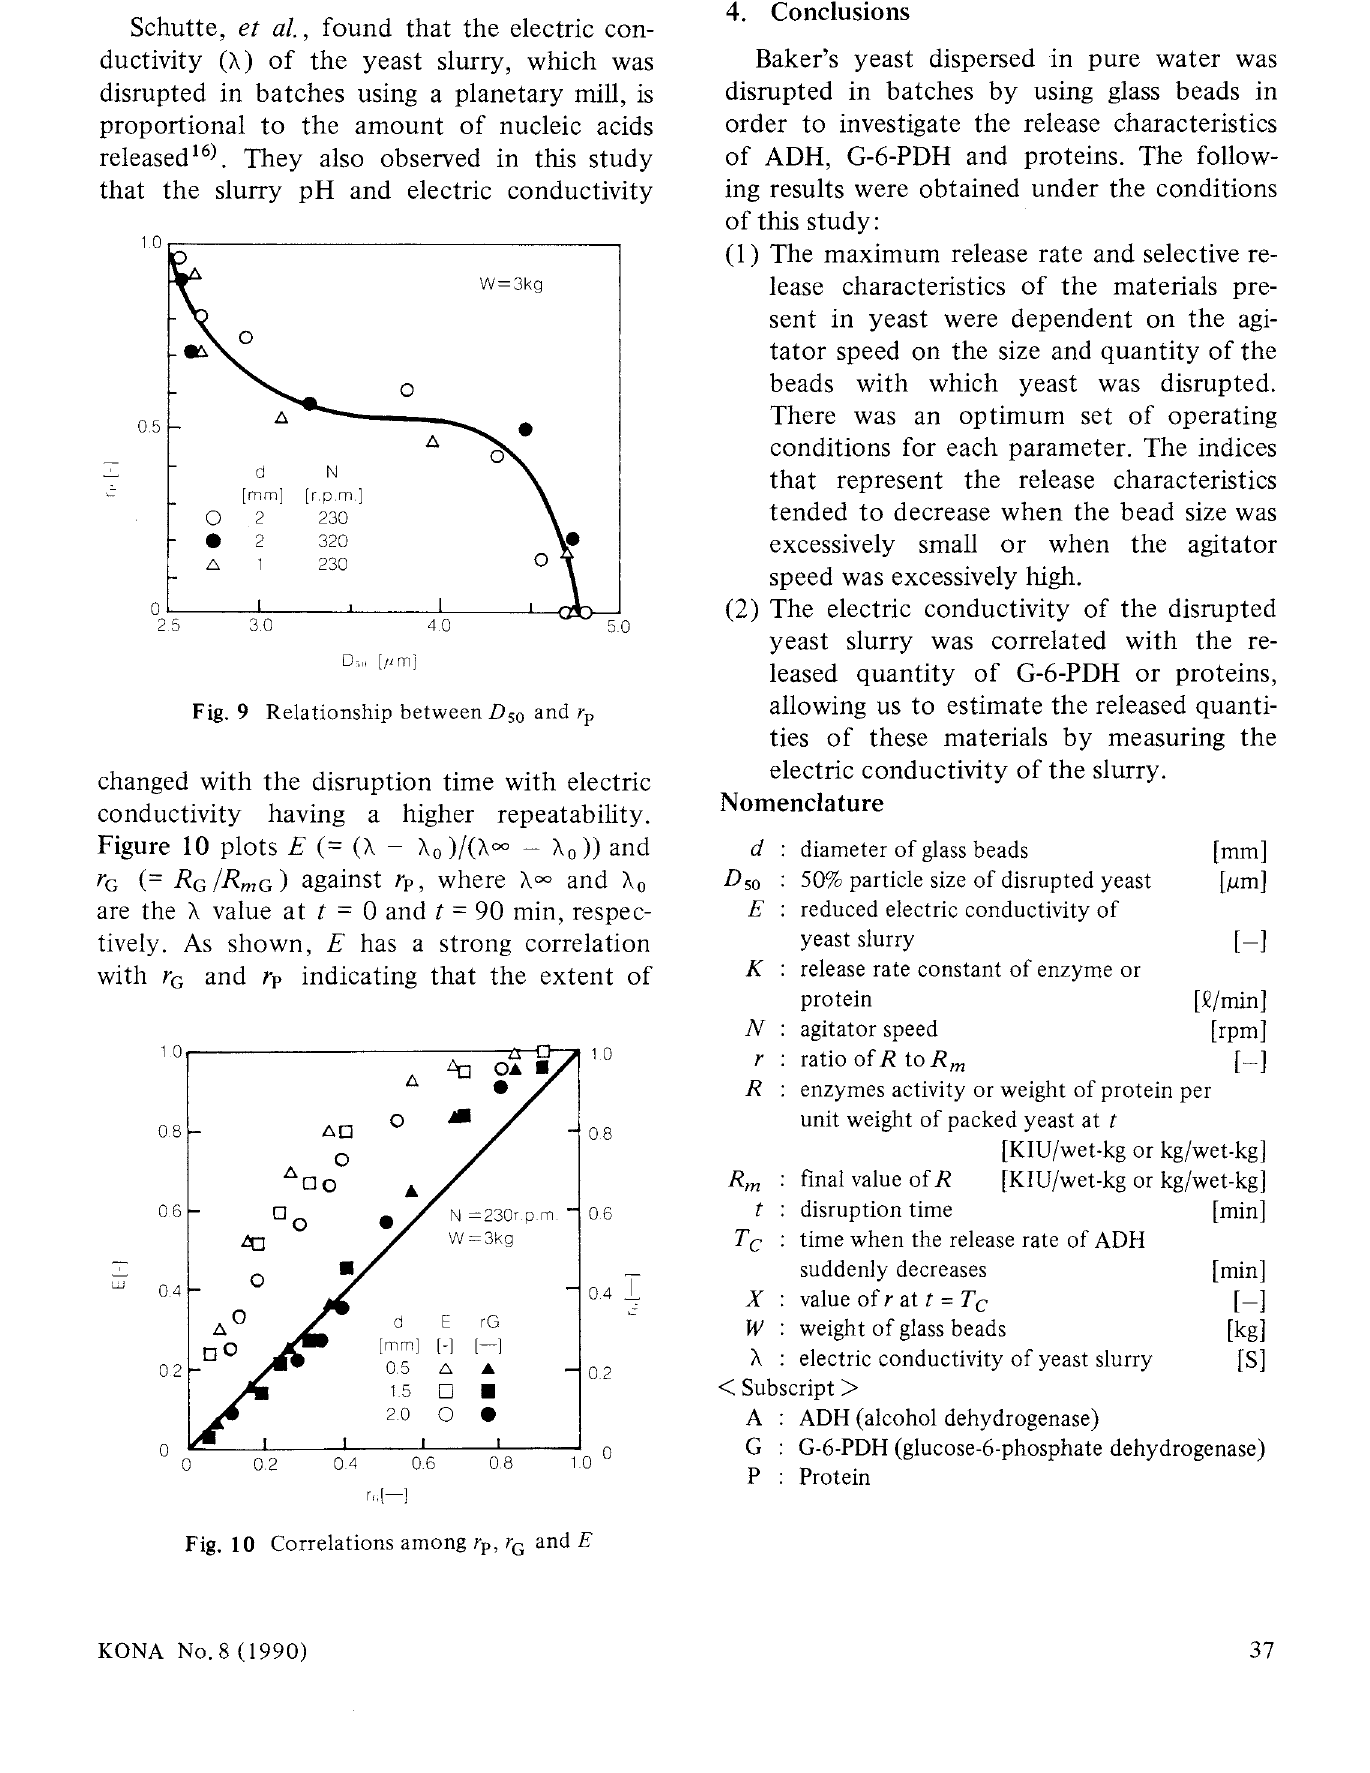
Fig. 9 Relationship between D